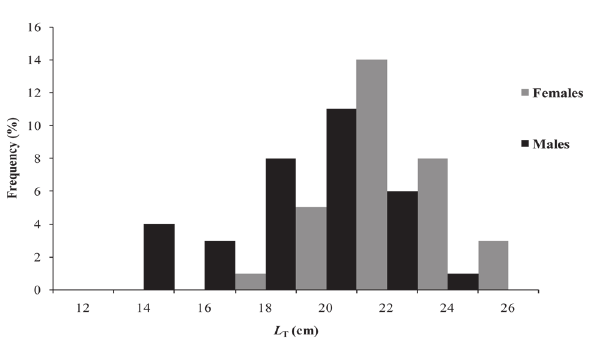
Fig. 6. Size-frequency distribution of females and males of A. afer during the reproductive period of 2008 and 2009. (Males, n=33; Females, n=31).